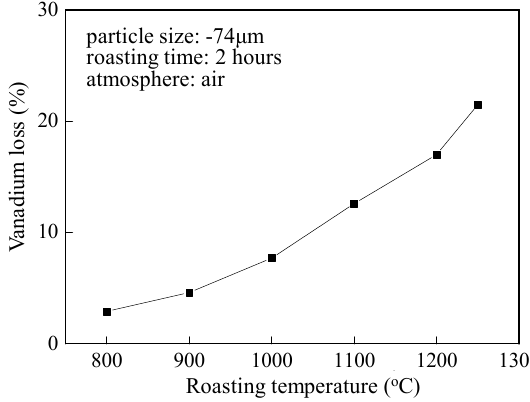
Figure 5. Effect of roasting temperature on vanadium loss.